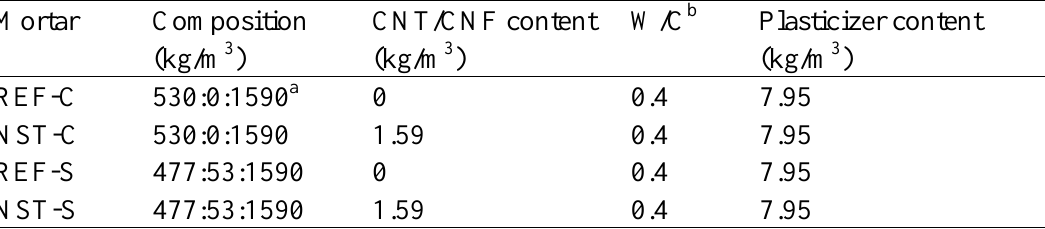
Table 4. Mortar mix